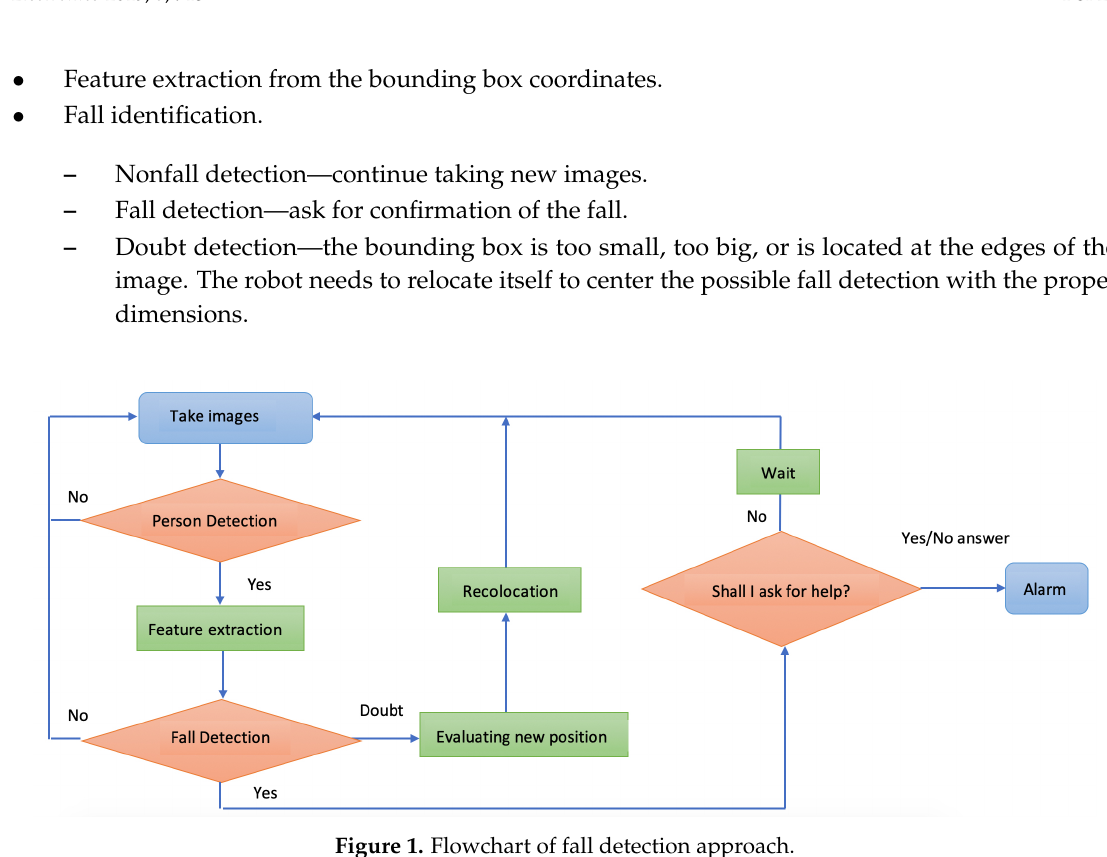
Figure 1. Flowchart of fall detection approach.